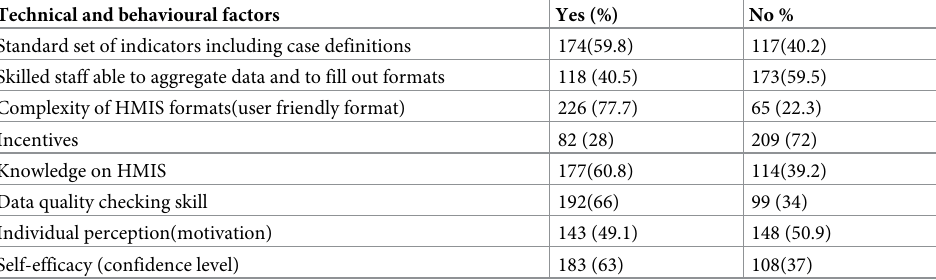
Table 3. Technical and behavioural factors of HMIS data quality in health centers of Hadiya zone, southern Ethio- pia